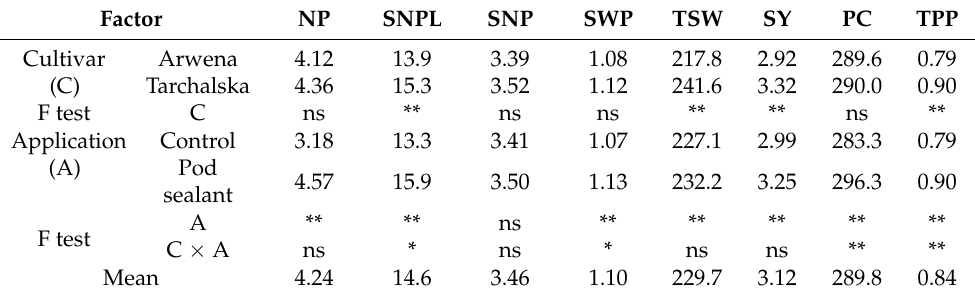
Table 5. Cultivar and pod sealant application effects on quantitative and qualitative traits in 2019.